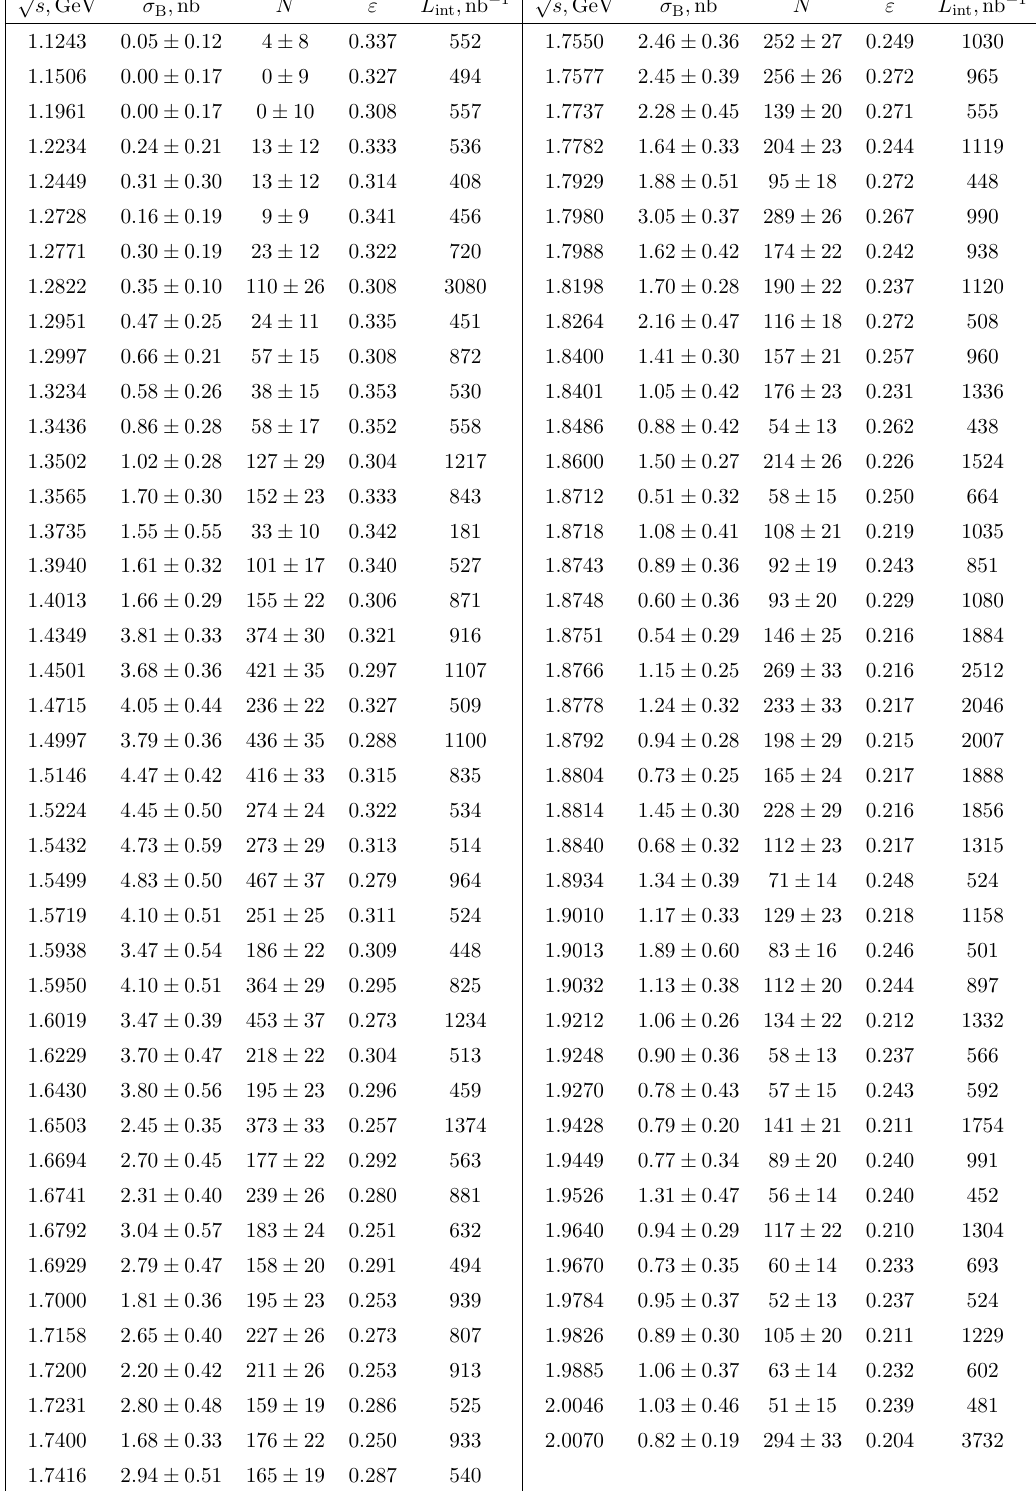
p Table 1 . The c.m. energy ( s ), the e + e (cid:0) ! (cid:17)(cid:25) + (cid:25) (cid:0) Born cross section ( (cid:27) B ), number of selected signal events ( N ), detection e(cid:14)ciency ( " ), integrated luminosity ( L int